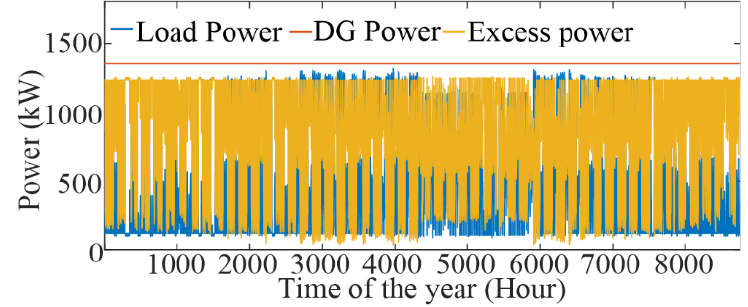
Figure 6. Power generation and consumption over the year: combination 1.